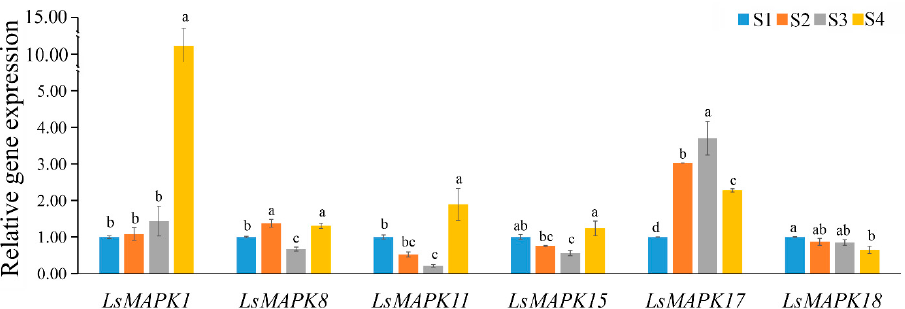
Figure 9. Expression profiles of LsMAPK genes at different lettuce stem enlargement periods. S1: diameter length is 1 cm; S2: diameter length is 2 cm; S3: diameter length is 3 cm; S4: diameter length is 4 cm. Bars with different lowercase letters (a, ab, bc, b, c) represented significantly different by Duncan’s multiple range tests at the 0.05 levels.